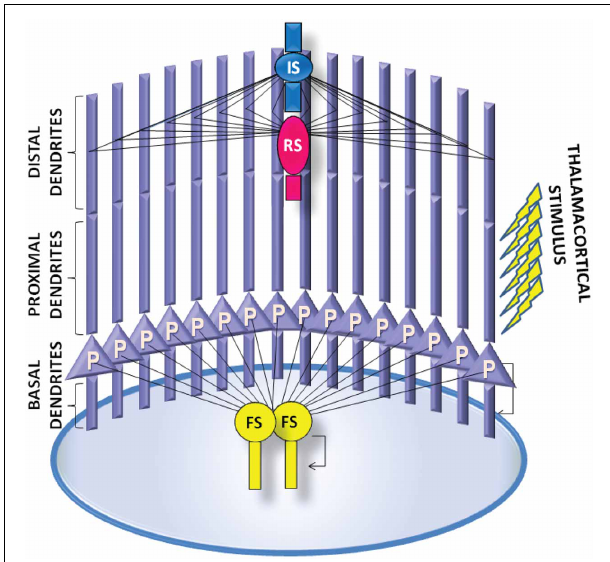
FIGURE 4 | A schematic of the PFC microcircuit. The PFC microcircuit consists of 16 pyramidal neuron models (P) and 4 interneuron models; 2 fast-spiking interneuron models (FS), 1 regular spiking interneuron model (RS) and 1 irregular-spiking interneuron model (IS). All neurons are fully connected through recurrent connections. The axon of each pyramidal neuron model projects to the basal dendrite of the other pyramidal neuron models. The axon of the FS interneuron model projects to the soma of all pyramidal neurons models. The axons of the RS and the IS interneuron models project to distal apical dendrite of all pyramidal neuron models. The axon of the IS interneuron model projects to the dendrite of the RS interneuron model. The pyramidal neuron and the FS interneuron models also form autaptic synapses. Persistent activity in the microcircuit is induced by providing external synaptic simulation to all 16 pyramidal neurons in their proximal apical